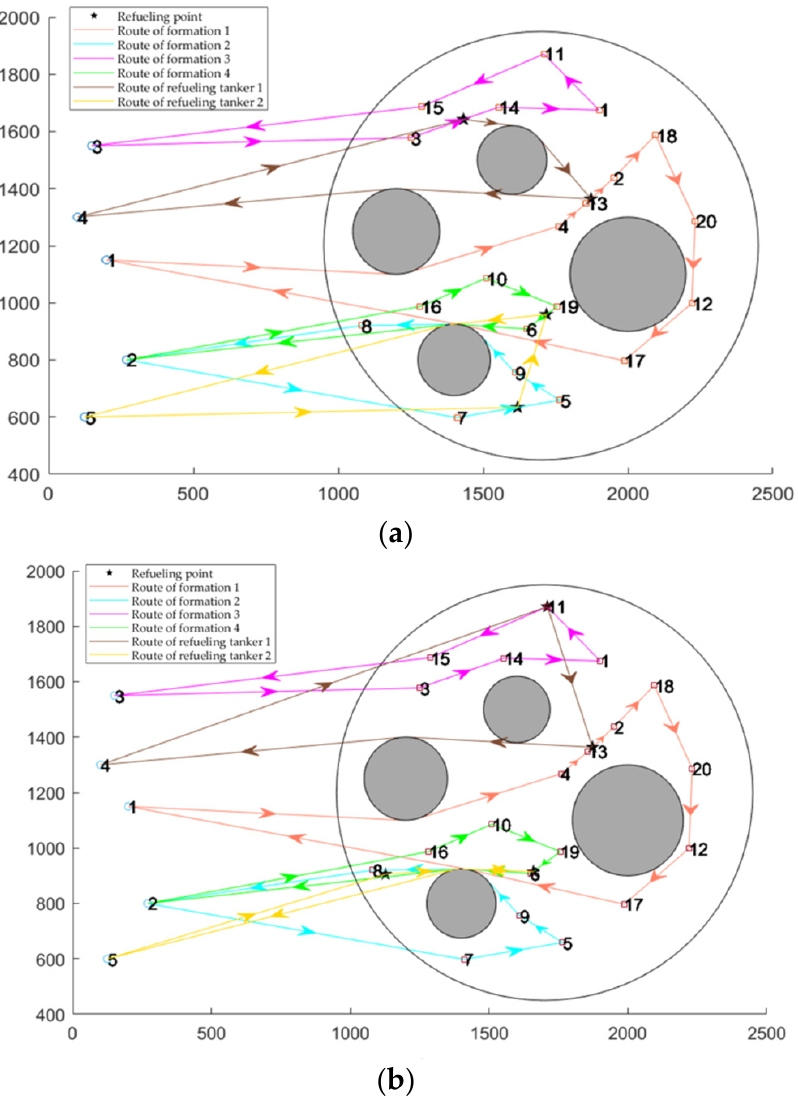
Figure 13. Collaborative route planning of the Pareto solution of infinite crowding distance obtained by improved NSGA-II: ( a ) Collaborative route planning of the Pareto solution (7552.20, 61.15); ( b ) Collaborative route planning of the Pareto solution (7233.83, 74.53).